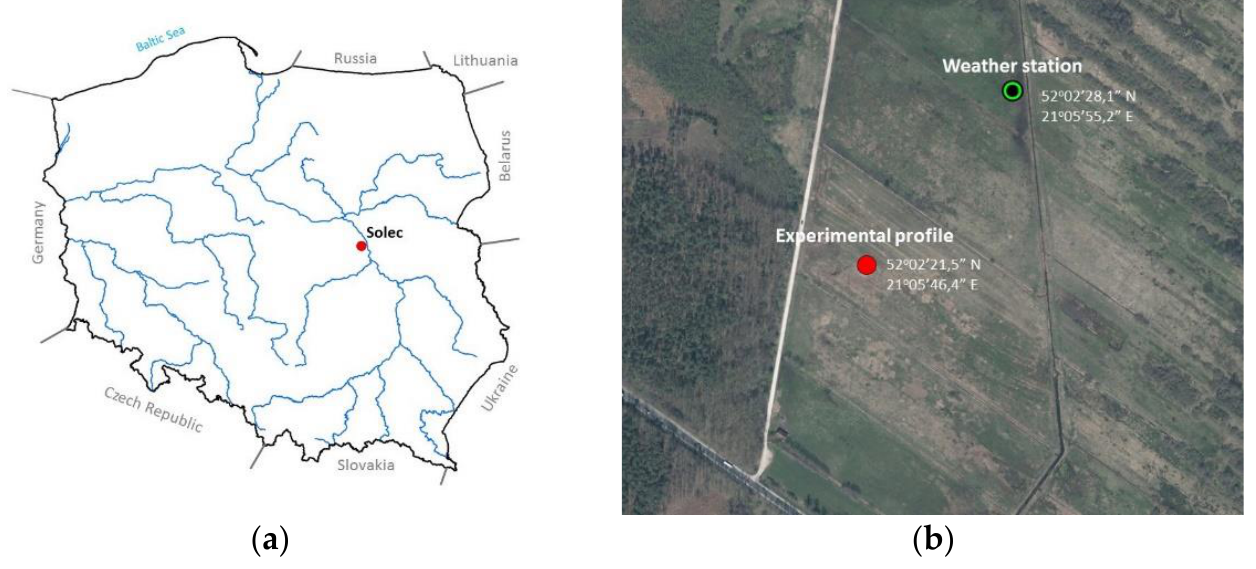
Figure 1. ( a ) Location of the Solec site within the territory of Poland; ( b ) the experimental profile and the weather station.